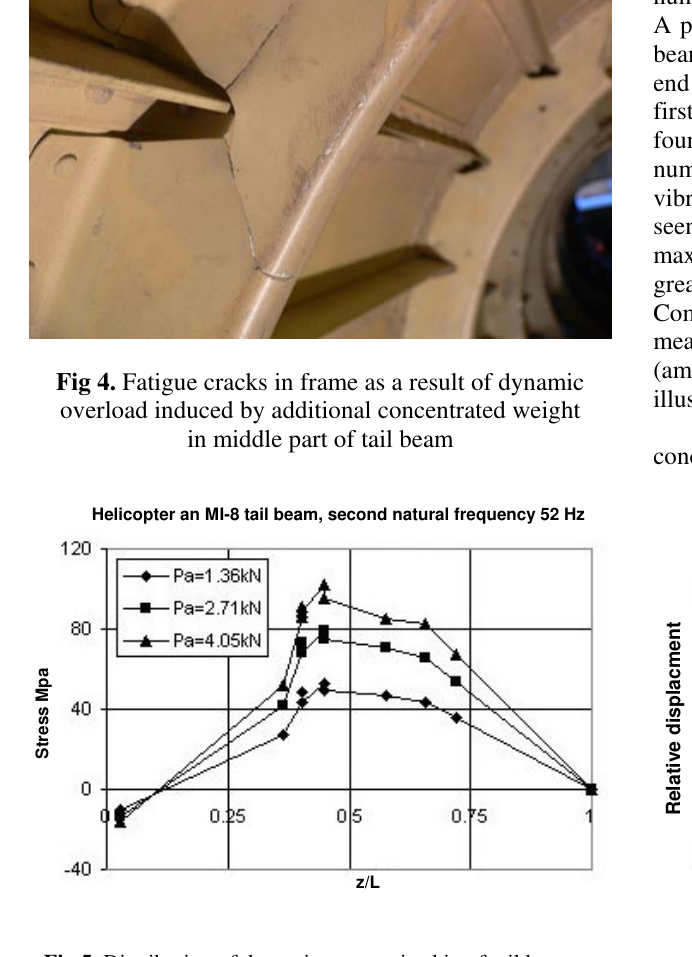
Fig 5. Distribution of dynamic stresses in skin of tail beam at forced vibration with second natural frequency